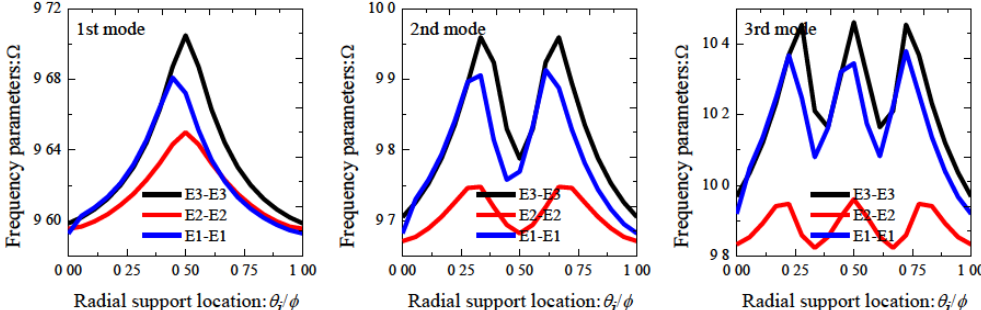
Figure 12: Variation of the frequency parameters Ω versus the radial support locations for a [0 ∘ /90 ∘ /90 ∘ /0 ∘ ] laminated annular sector plate with a θ direction internal radial support ( E 1 / E 2 =15, a / b =0.5, h / b =0.1, ϕ = π )